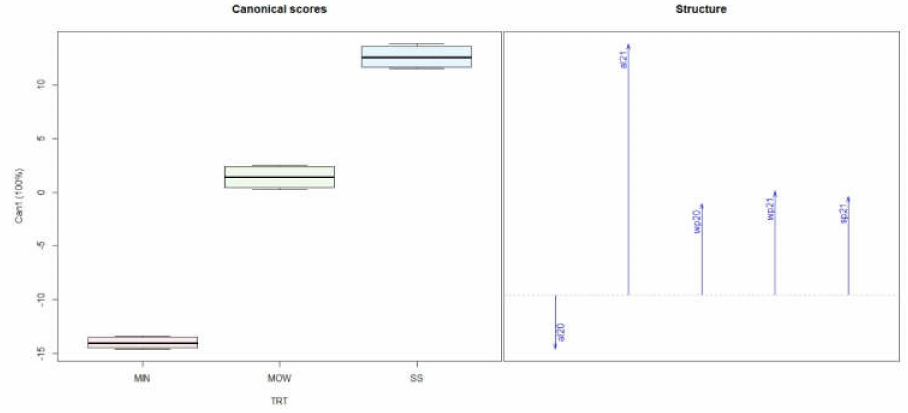
Figure 7. Discriminant canonical analysis of biomass parameter in 2020 and 2021. MIN: min- eral; MOW: municipal organic waste compost; SS: sewage sludge compost; al = abscised leaves; wp = winter pruning; sp = summer